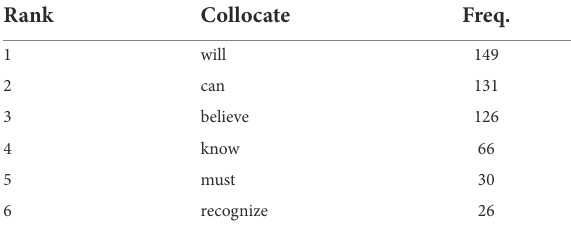
TABLE 4 Top six voice-intensifying/mitigating collocates of